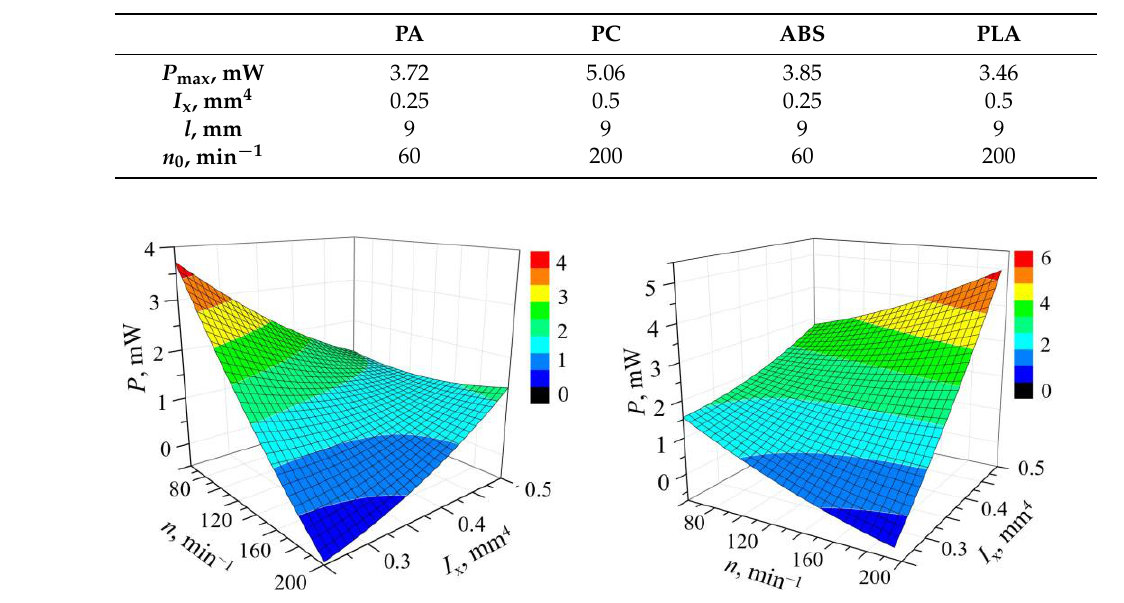
Table 2. Maximal power outputs and optimal parameters for different plectrum materials [34].